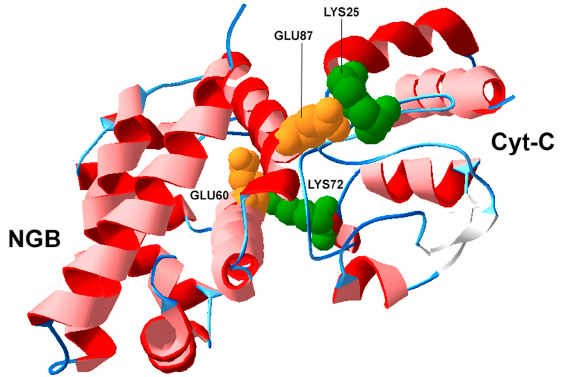
Figure 3. Putative structure predicted by docking studies [84] between human neuroglobin (NGB; PDB code: 1OJ6) and human cytochrome c (Cyt-C; PDB code: 3NWV). Relevant amino acids at the interaction interface are highlighted in color. Interface residues Glu60 and Glu87 on NGB are shown in yellow, the corresponding residues on Cyt-C (Lys72 and Lys25, respectively) in green.